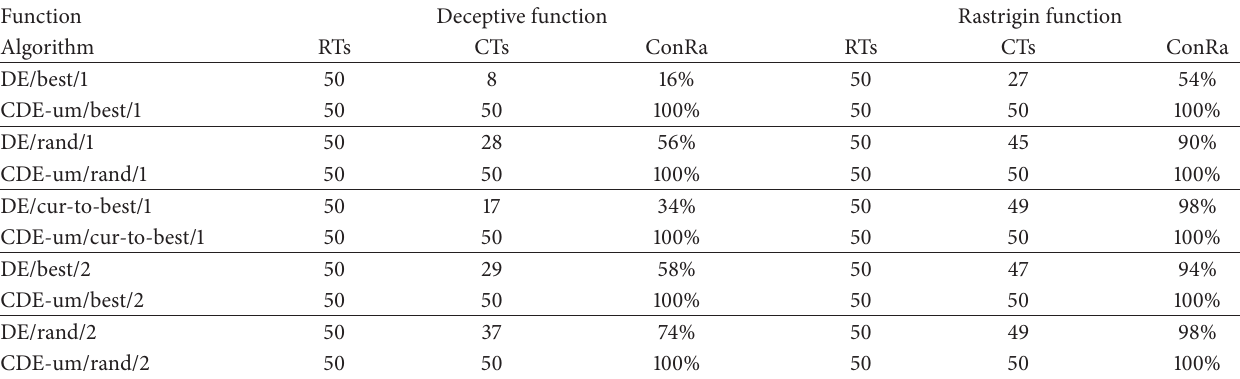
Table 3: Statistical analysis of Tables 1 and 2.